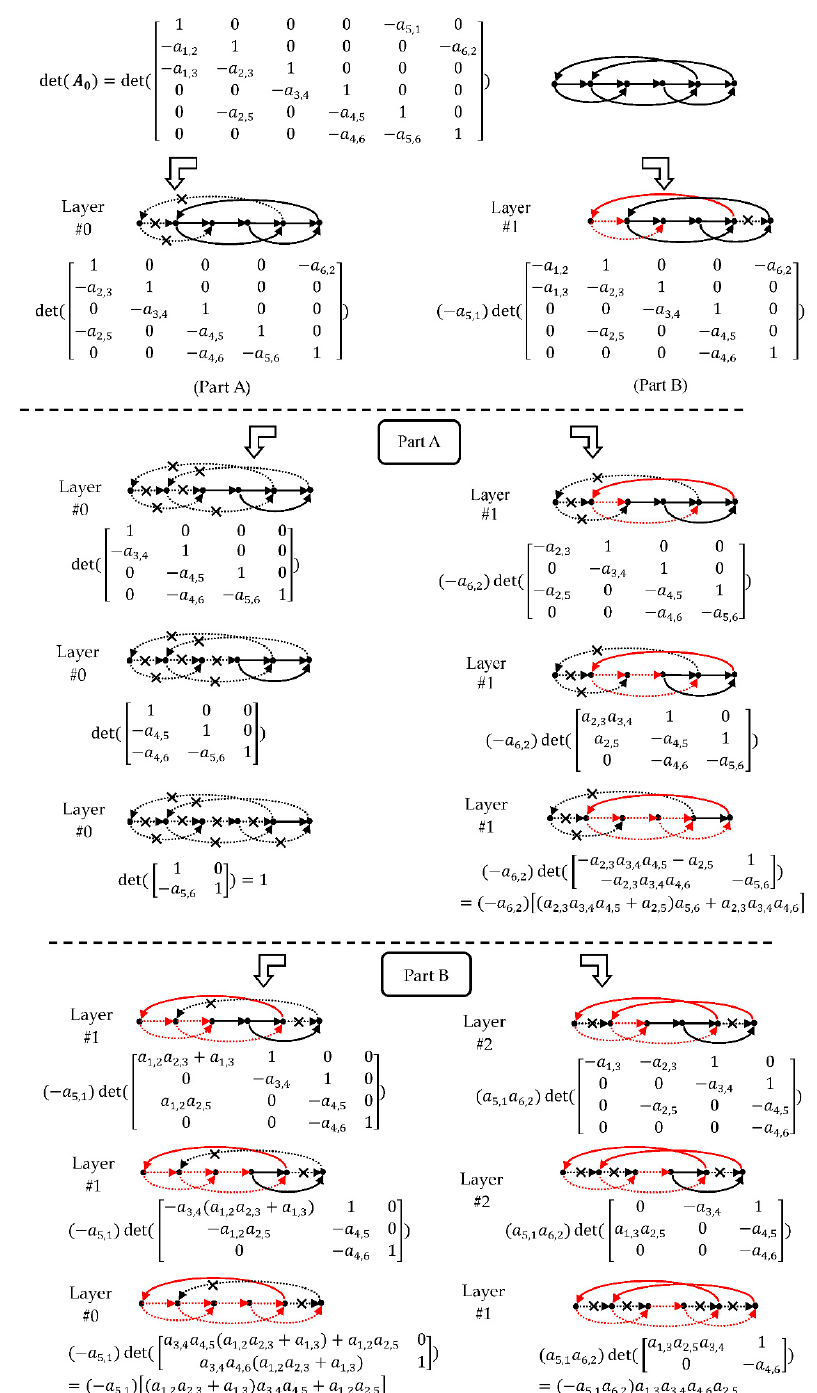
Figure 3. Graph decomposition of example 1.